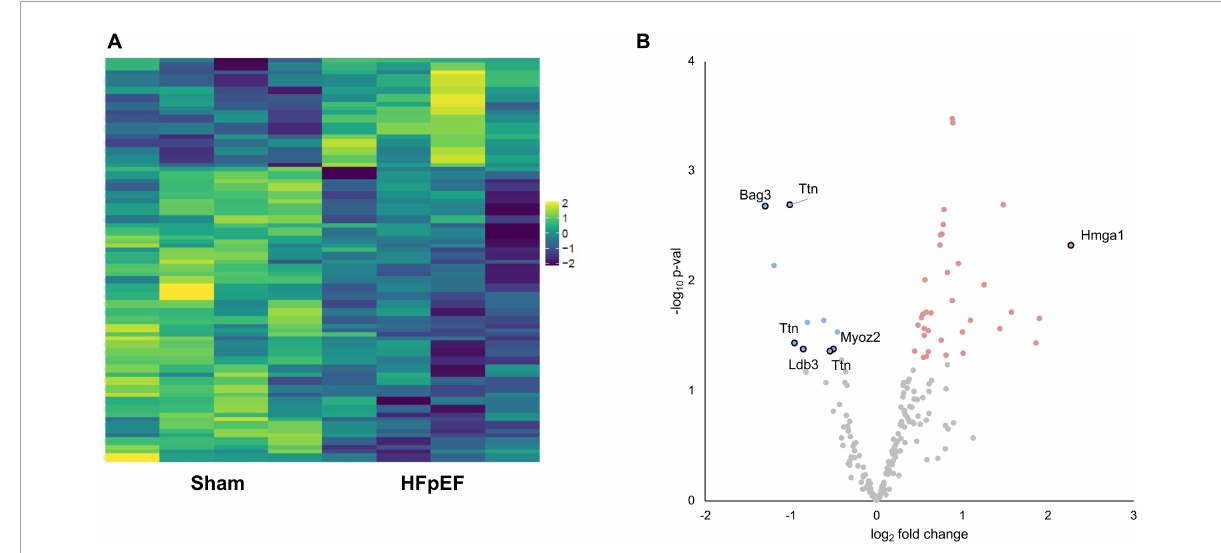
FIGURE4 Phosphoproteomics analysis. (A) Heatmap of the differentially expressed phosphosites. (B) Volcano plot presenting log-transformed p -values ( t -test) associated with individual significantly altered phosphosites plotted against log-transformed fold change in abundance between the left ventricles in Sham and HFpEF mice. Blue and red dots represent up-regulation and down-regulation in HFpEF ( N = 4) vs. Sham ( N = 4),